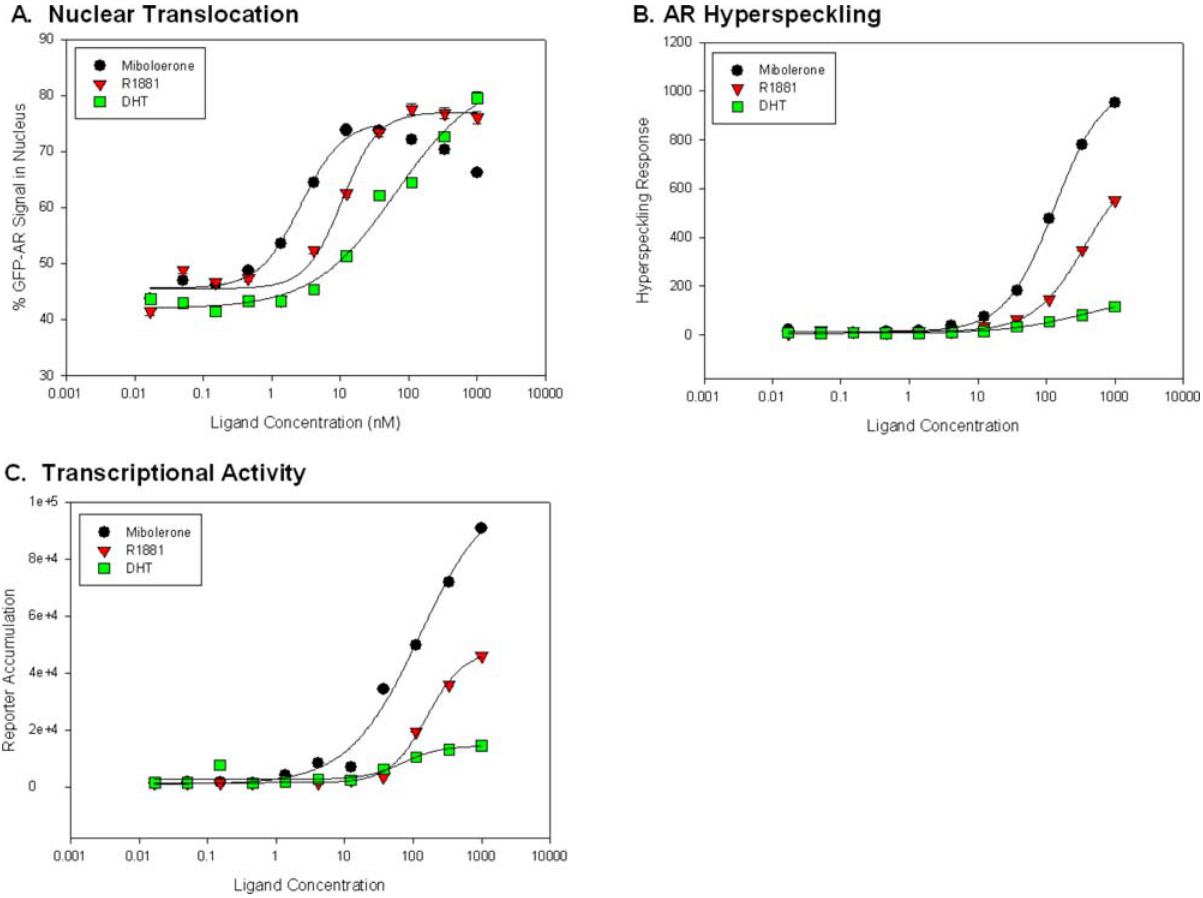
Figure 8. Differential responses of the F764L AR mutation to a panel of agonist. The effects of the F764L mutation on AR nuclear translocation ( A ), nuclear hyperspeckling ( B ), and transcriptional reporter gene activity ( C ) in HeLa cells with treated with R1881 (red), mibolerone (black), or DHT (green). Cells stably expressing F764L form of AR were transfected with pARR-2PB-dsRED2skl reporter vector and maintained in 5% SD-FBS media for 12 hr. Cells were treated with indicated compound for 18 hr in 5%SD-FBS. When possible, EC50 values were calculated using SigmaPlot 4-parameter curve fitting tool and presented 6 std. error. Data represents average of 4 experiments.